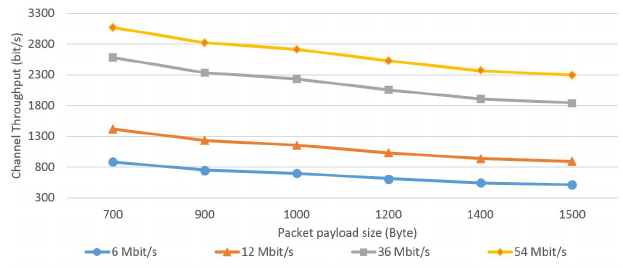
Figure 6: Total throughput for both pairs in Scenario 1.